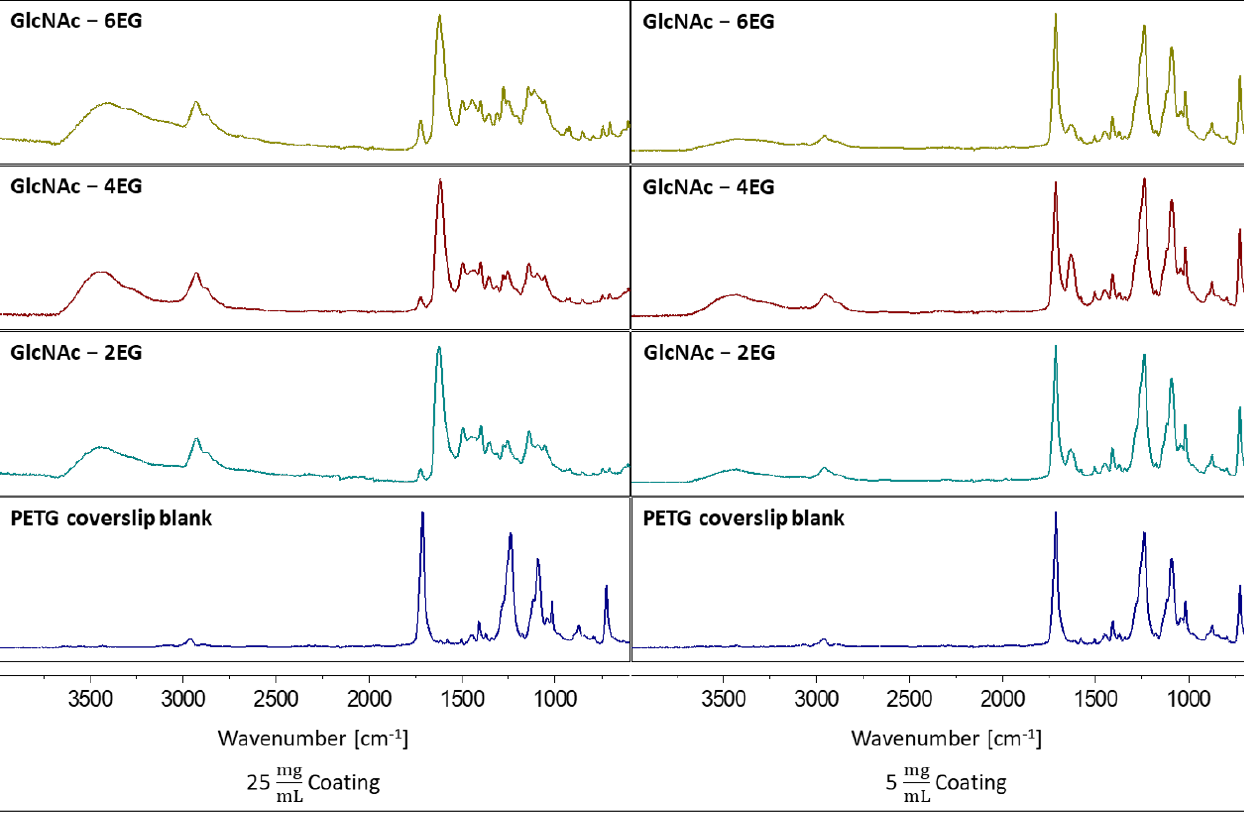
Figure 3. Recorded Fourier transform-infrared spectra of selected functional PDMAm-co-P-benzophenone-MA-co-P-GlcNAc-OEG-MA coatings (Table 1) containing 5% GlcNAc copolymer and linkers with 2, 4 and 6 ethylene glycol (EG) units. Coatings obtained with 25 mg mL −1 coatings could be analyzed properly, whereas with 5 mg mL −1 coatings, the terephthalate group of the PETG was the dominant signal in the recorded IR spectra.